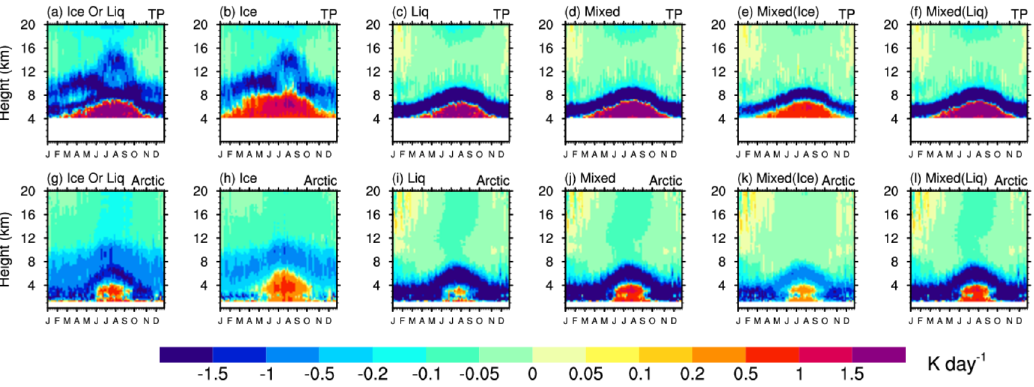
Figure 5. As in Figure 4, but for the LW CRE.